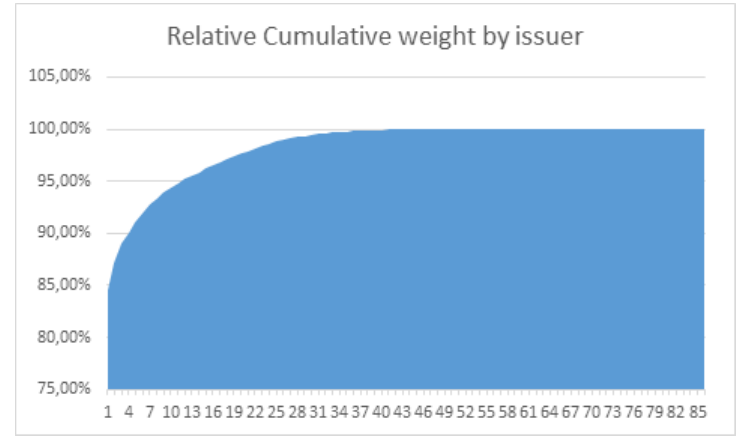
Figure 1: Plot of the cumulative weight of the bond